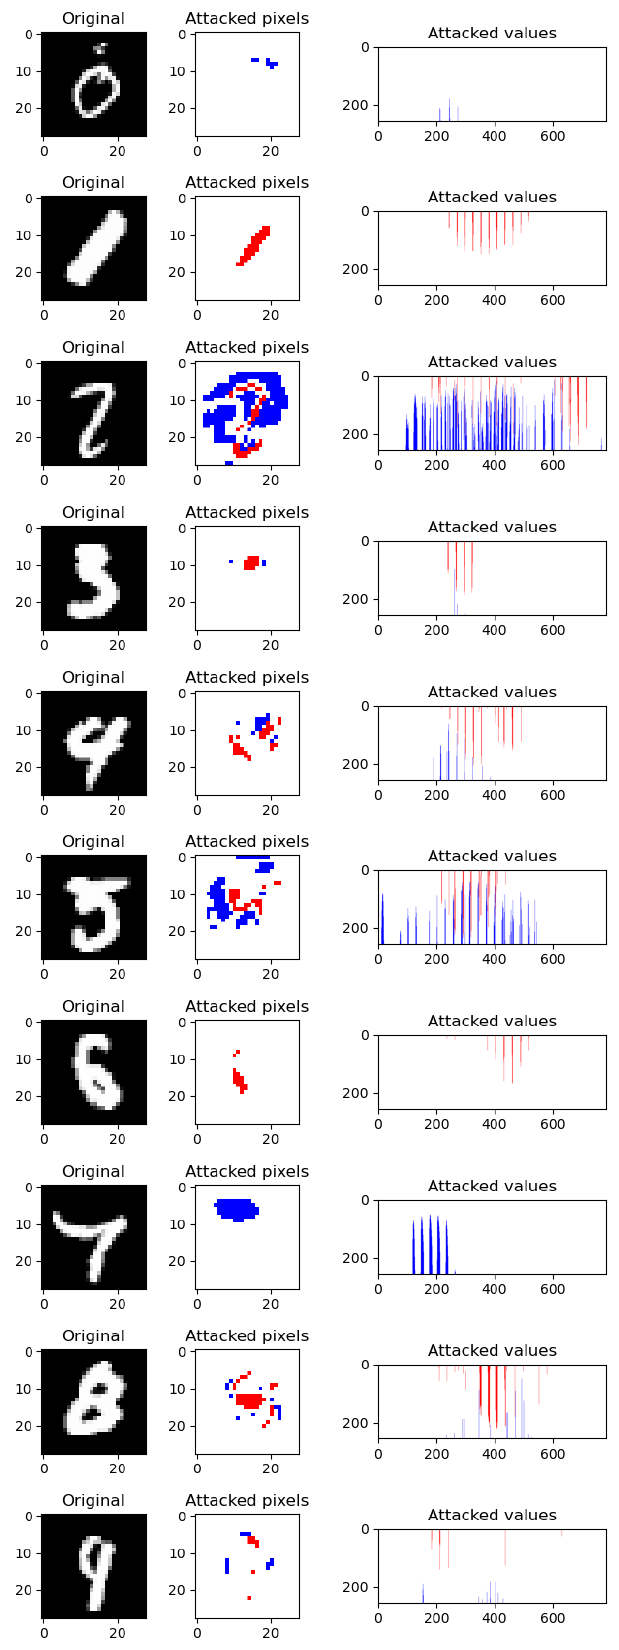
Figure 2. One-pixel attack for each digit in